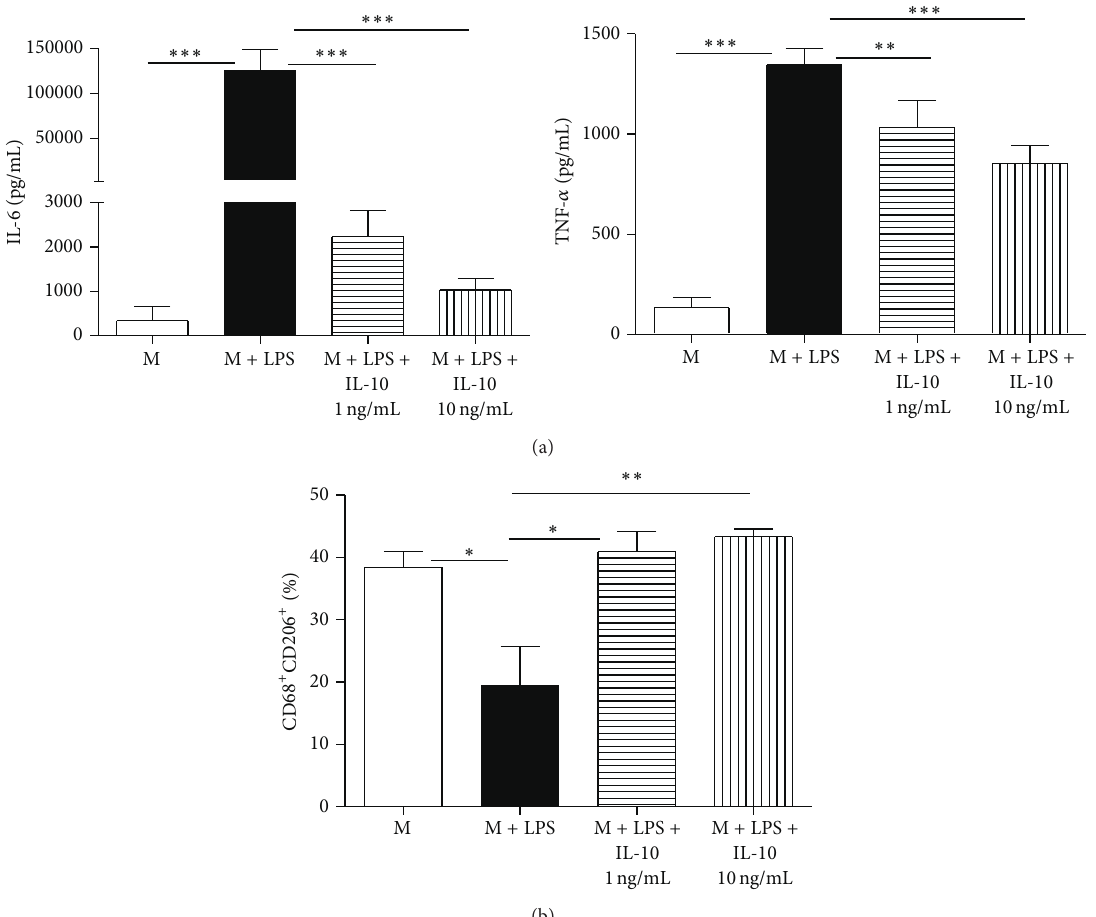
Figure 7: IL-10 mimics the effects of educated macrophages. (a) M (2 × 10 6 cells/well) were pretreated with or without IL-10 (1ng/mL and 10ng/mL) for 6 hours and then incubated with LPS (10ng/mL) for another 24 hours. Culture supernatants were harvested for cytokine assay via Luminex. (b) Percentage of CD68 + CD206 + macrophages after IL-10 and LPS treatment was determined via flow cytometry. All data are expressed as mean ± SEM; 𝑛 = 4 per group. ∗ 𝑝 < 0.05 ; ∗∗ 𝑝 < 0.01 ; and ∗∗∗ 𝑝 < 0.001